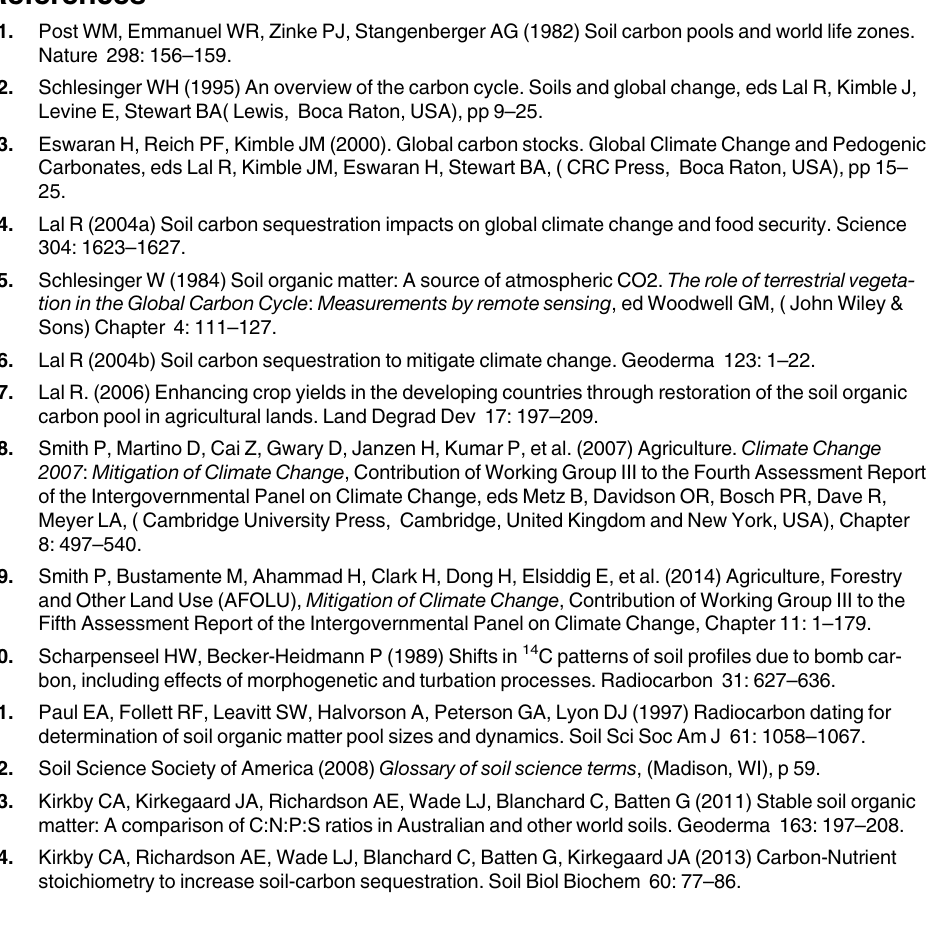
S1 Table. Crop biomass and nutrient data. S2 Table. Nutrients added to facilitate humification of 30% of stubble-C. S3 Table. Soil nutrient concentrations (%), loads (t ha-1) and ratios (C:N, C:P, and C:S) in 2006 and 2012. S4 Table. Fertiliser nutrients added for normal crop requirements and NPS mass balance